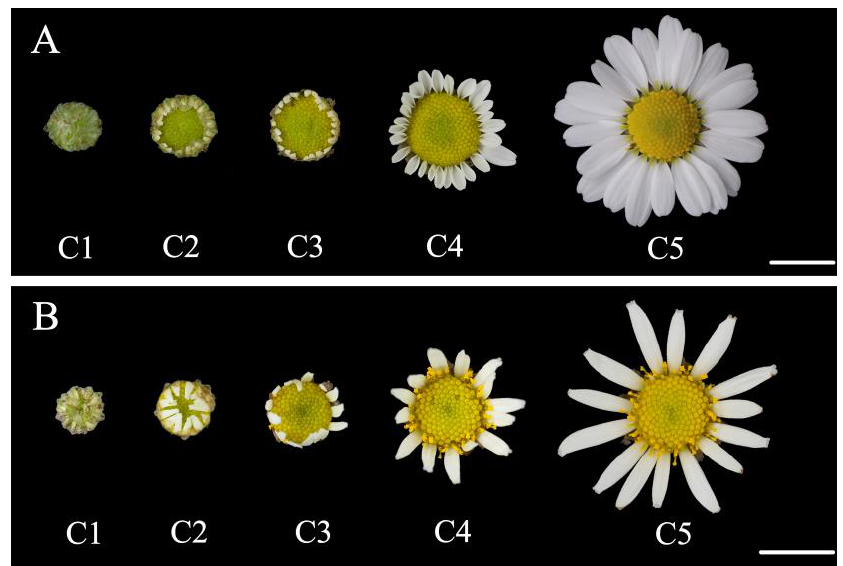
Figure 1. Characterization of flat-type line CVW and tubular type line CVT of Chrysanthemum vestitum . ( A ) The five different opening stages of the CVW capitula. ( B ) The five different opening stages of the CVT capitula. Scale bar = 1 cm.